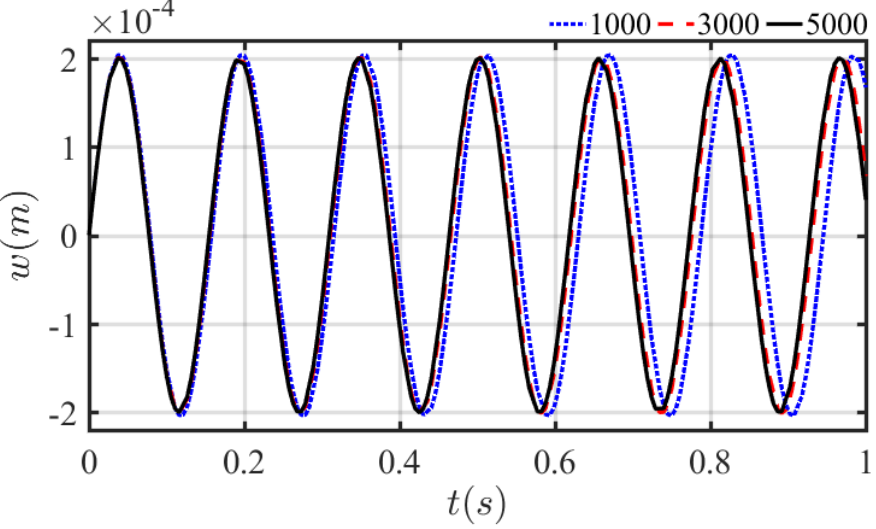
Figure 11. Effects of the GPL length-to-thickness ratio on the GPLRC pipes conveying fluid nonlinear transient vibration.